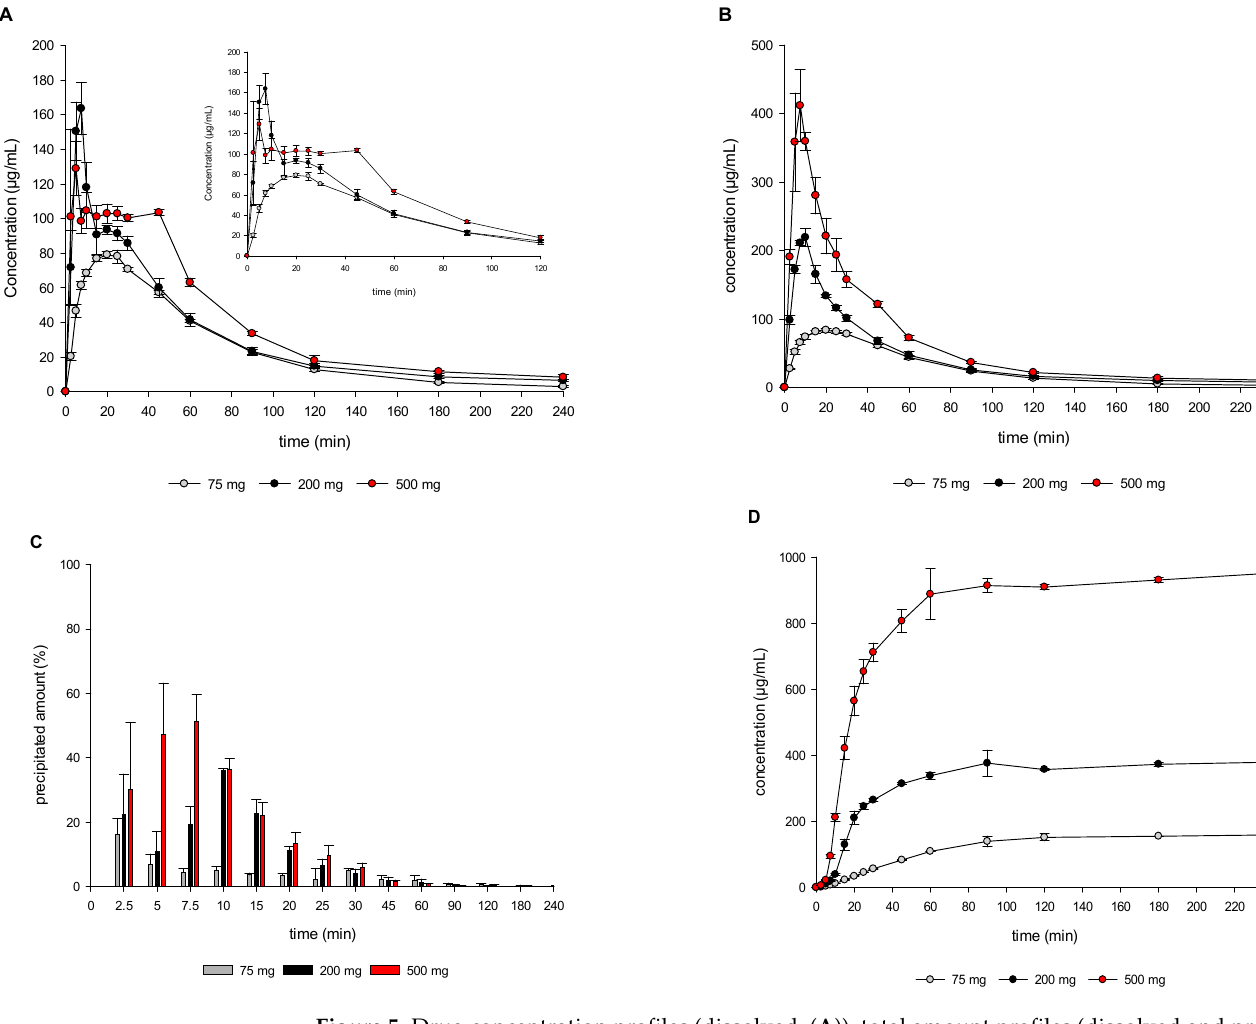
Figure 5. Drug concentration profiles (dissolved, ( A )), total amount profiles (dissolved and precip- itate, ( B )), and precipitated amount ( C ) obtained from the aqueous filtered and un-filtered phase; partitioning profiles ( D ) obtained from the organic phase during in vitro DTPS experiments using 75, 200, and 500 mg MSC-A as OS; VR 0.8 and t 1/2 9 min. Means ± SD, n = 3. Figure 6B shows the precipitated amount of drug in the intestinal compartment in %, which was calculated based on the theoretically transferred drug amount at every sampling time point (see also Section 2.5). For the 75 mg OS dose, the precipitated amount was ≤ 20% until 60 min. Pronounced precipitation of the 75 mg dose occurred from the sampling time point of 60 min to 120 min. In contrast, for the higher doses of 200 mg and 500 mg OS, the overall precipitated fraction was found to be much higher, with >80% of the drug precipitated after 30